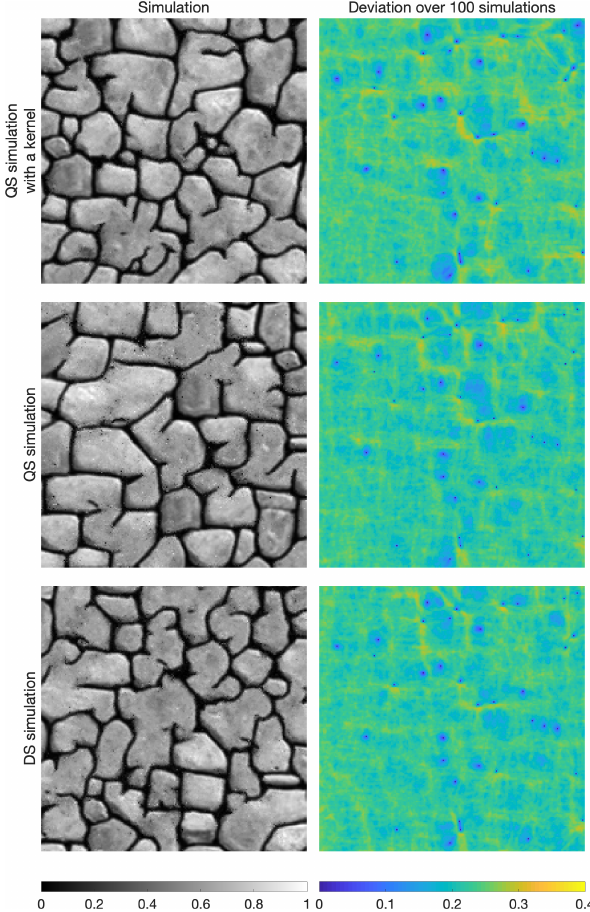
Figure 5. Examples of conditional simulations and their standard deviation over 100 realizations that are used in the benchmark be- tween QS and